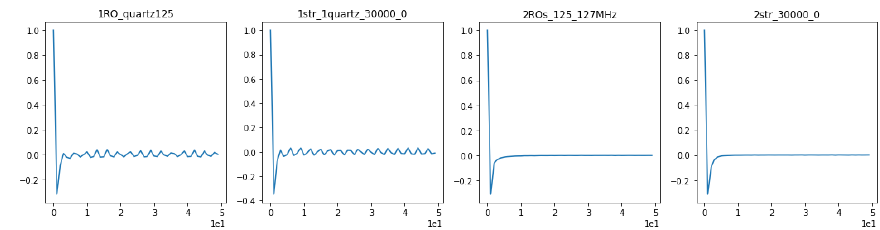
Figure 17: Autocorrelations of counter values, including large lags (variance-stable estimate ˆ ρ b )